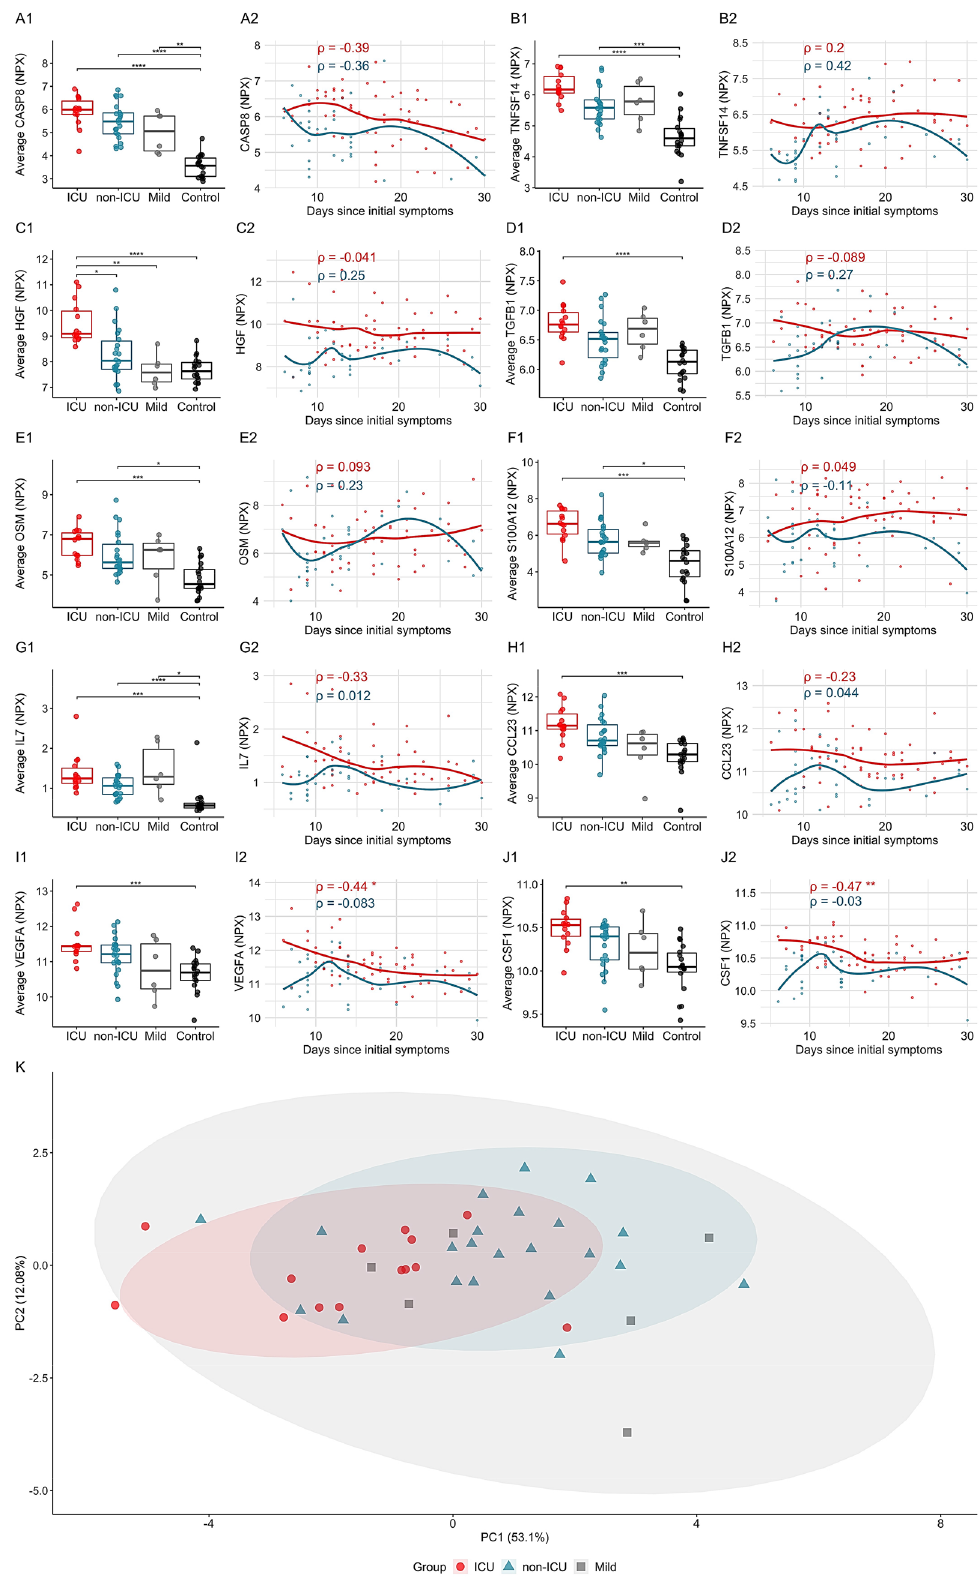
Figure 3. Consistently increased markers of apoptosis and tissue-inflammation in COVID-19 patients. Examples of 10 proteins, including markers associated with apoptotic mechanisms, with increased levels in ICU patients over the disease course. ( A1 – J2 ) PEA profiling NPX values per individual (1) and scatterplots (2) where x-axis denotes time in days since the start of the symptoms, y-axis corresponds to the measurement’s level and the group specific lines are calculated via loess regression. ( K ) PCA plot calculated based on 10 markers’ average levels consistently upregulated in